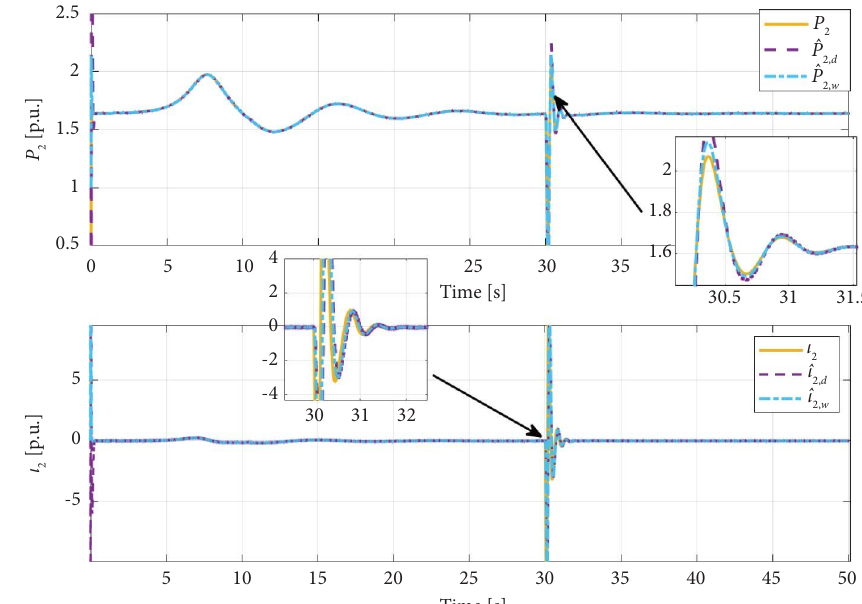
Figure 5: Comparison between the L-D GE estimators: the electrical power and nonlinear interconnection term of generator